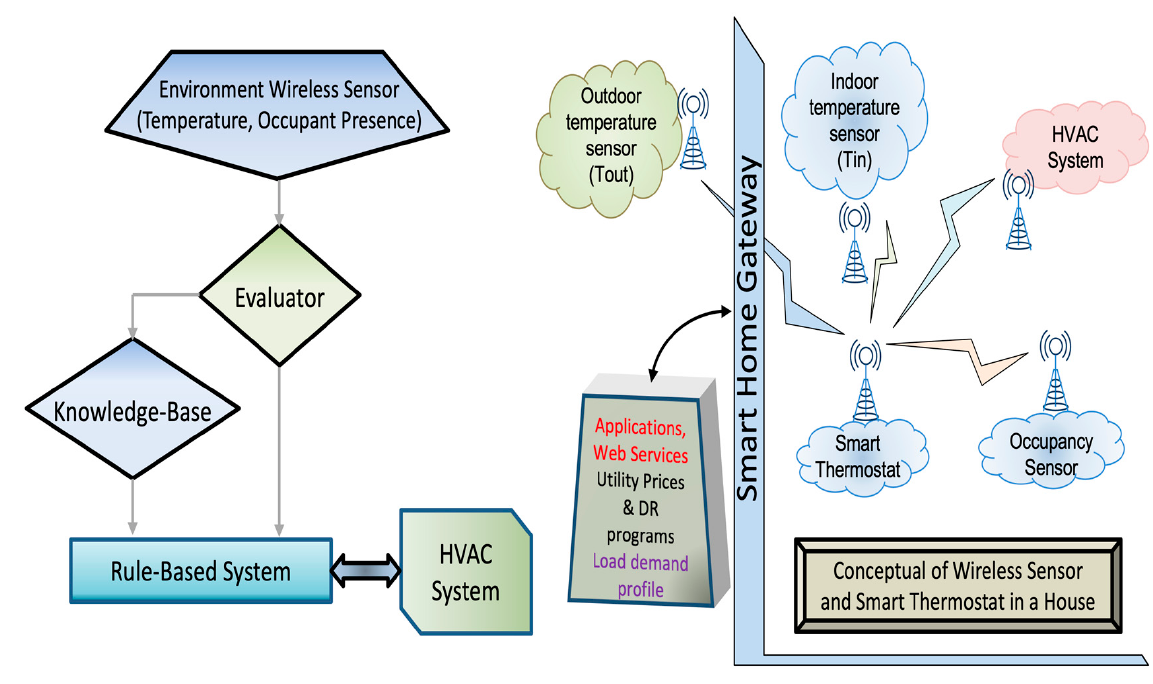
Figure 4. Rules-based control systems and wireless sensors [48] .